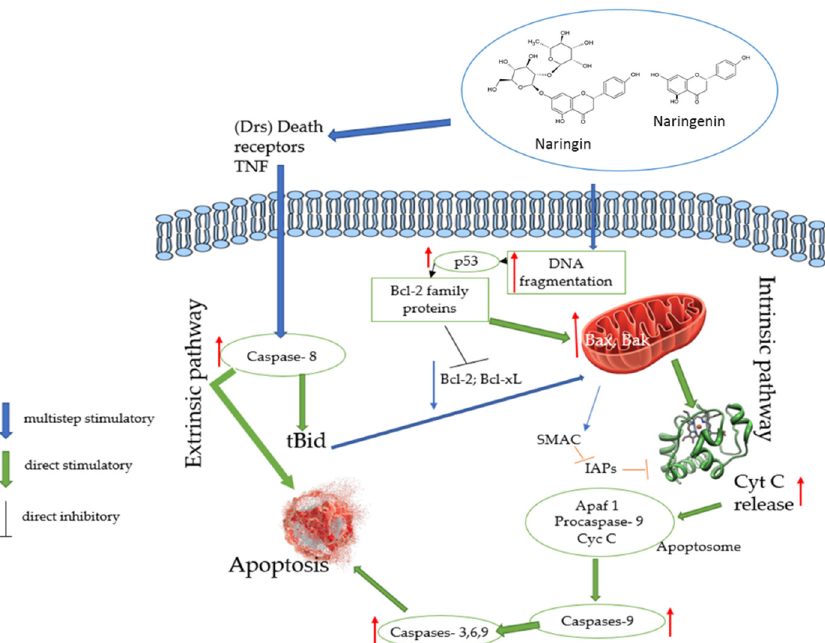
Figure 5. Naringin and naringenin targets in extrinsic and intrinsic apoptosis pathways. Red arrows show the effects of flavonoid activation and blue the effects of flavonoid suppression. The intrinsic or mitochondrial apoptosis pathway is initiated by releasing cytochrome c (Cyt c) to the mitochondria, which binds to apoptotic protease activating factor 1 (Apaf-1), and procaspase-9 to form the apoptosome. Then, caspase-9 is cleaved, and effector caspases are activated. The extrinsic or cytoplasmatic apoptotic pathway is activated at the cell surface by binding a specific ligand to its corresponding cell surface death receptor. Death receptors promote the recruitment of adapter proteins, which can interact with caspase-8 to generate its active form. Caspase-8 can also interact with the intrinsic apoptotic pathway by splitting pro-apoptotic proteins (tBid), which results in cytochrome c release. Anti-apoptotic members of the Bcl-2 family (B-cell lymphoma protein 2 (Bcl-2) and Bcl-2 homolog splice variants (Bcl-xL)) can block apoptosis, but its pro-apoptotic members (Bax and tBid) can also regulate programmed cell death. Other mitochondrial proteins can inhibit both initiator and effector caspases